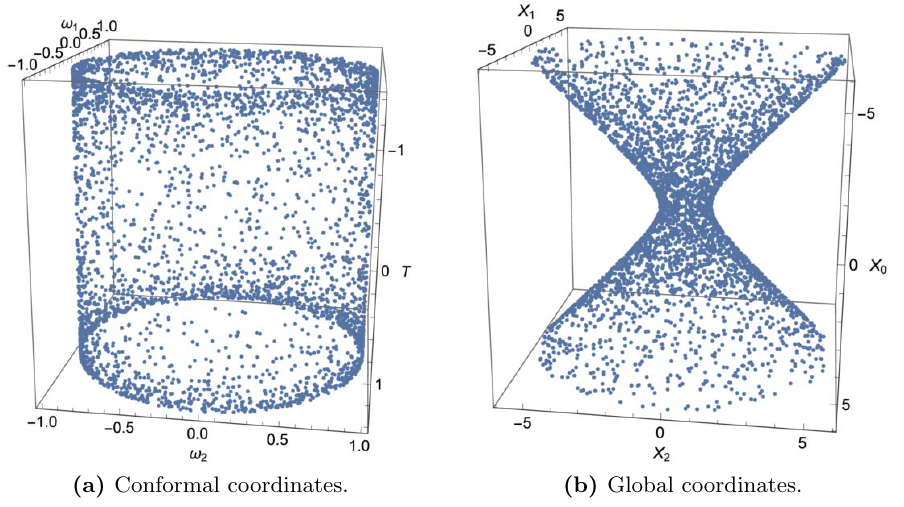
Figure 1. A sprinkling of N = 4000 elements for the time interval